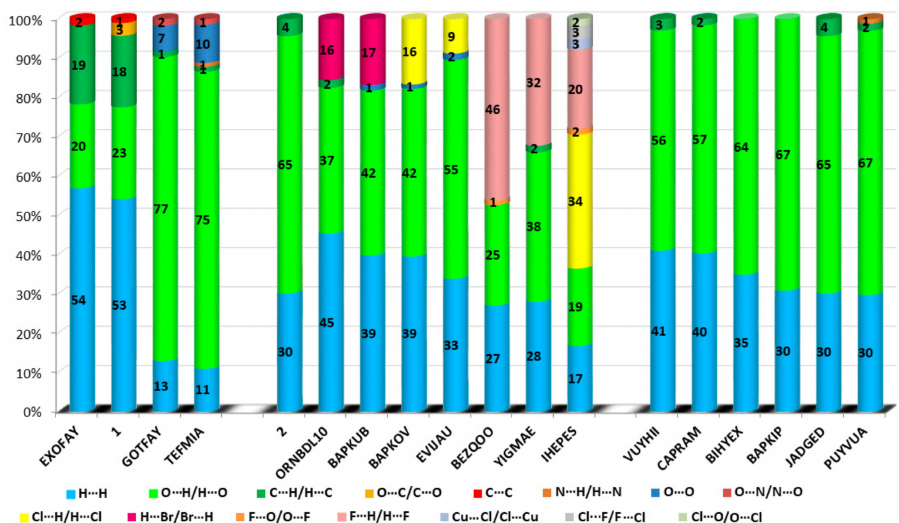
Figure 9. Relative contributions of the di ff erent interactions to the Hirshfeld surface for all ornithine derivatives.